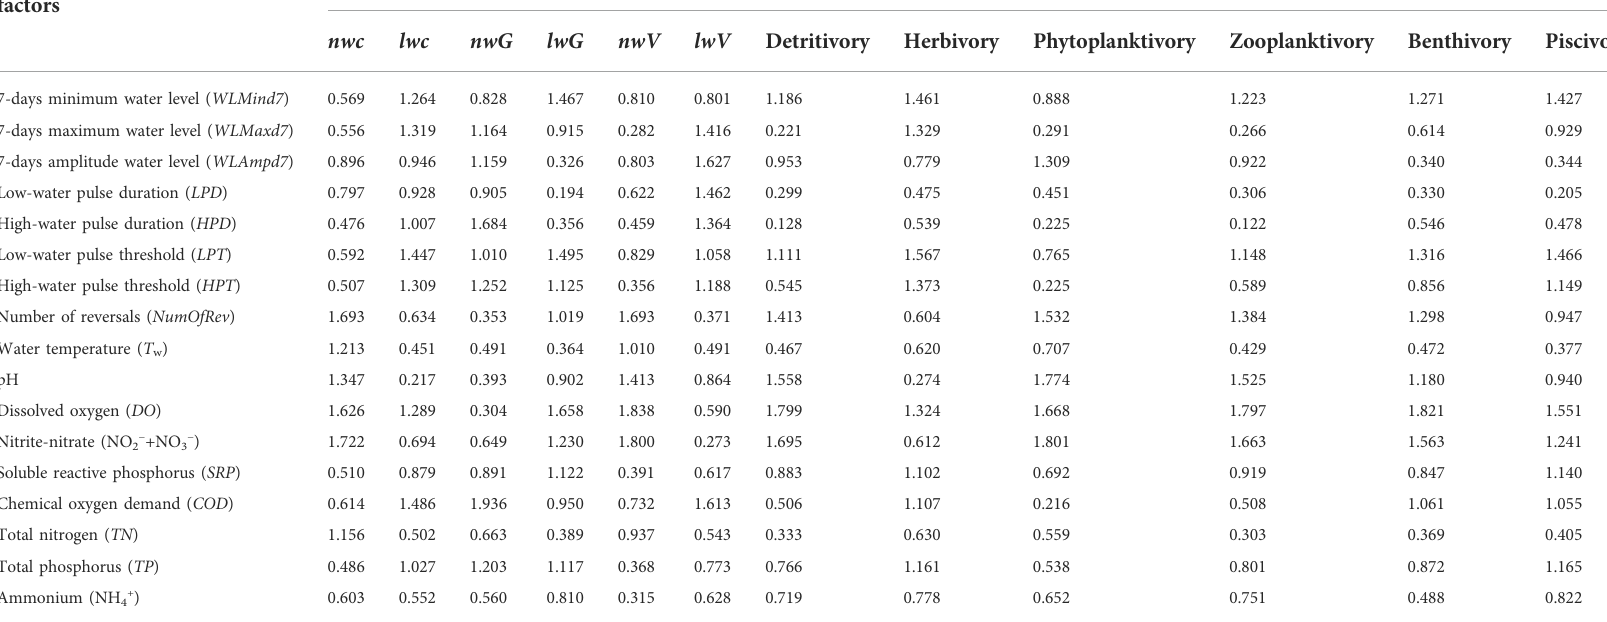
TABLE4Meanvaluesofthevariableimportanceintheprojection( VIP )obtainedviapartialleast-squaresregression.Metricsarethenode-weighted(nw)andlink-weighted(lw)connectance(C),generality (G), and vulnerability (V), and six fl ow-based ecosystem functioning